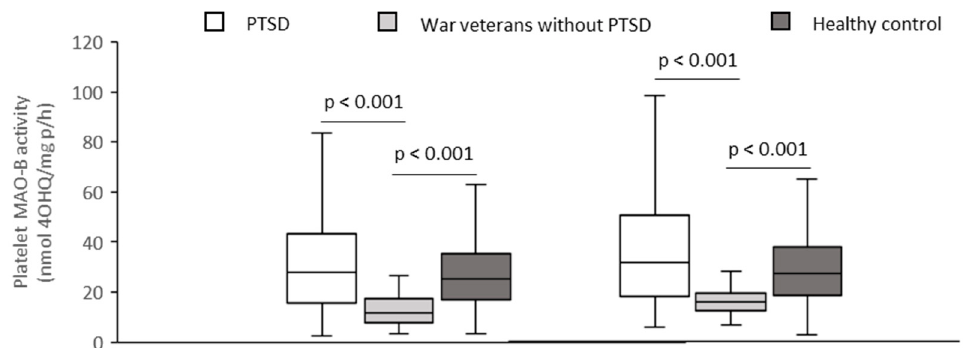
Figure 1. Platelet MAO-B activity in subjects with and without PTSD and healthy control subjects, subdivided according to smoking status.